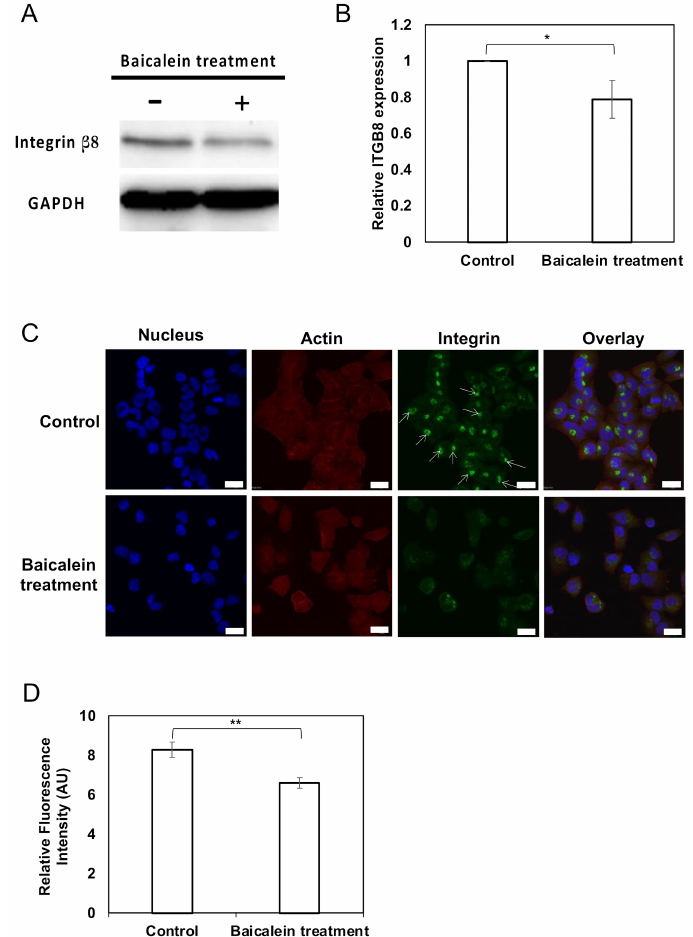
Figure 4. Validation of integrin β 8 expression in baicalein-treated NPC cells. ( A ) Protein expression of integrin β 8 in HK-1 cells with and without baicalein treatment. GAPDH was used as a loading control. Blots were cropped from the same gel to improve the clarity of protein-specific bands. ( B ) The relative protein expression of integrin β 8 was determined by Western immunoblotting. ( C ) Immunofluorescence staining of intracellular integrin β 8 protein in HK-1 cells. HK-1 cells were treated with 10 µ M baicalein for 24 h and fixed with 4% paraformaldehyde. The cells were then stained with primary integrin β 8 antibody, followed by Alexa-488-conjugated anti-mouse IgG. DAPI and TRITC-labeled phalloidin were used to counterstain the nucleus and actin, respectively. The arrows indicate the distinct pattern of integrin β 8 in control HK-1 cells. Scale bar represents 20 µ m. ( D ) The relative fluorescence intensity of baicalein-treated HK-1 cells compared to the control was determined by ImageJ software. All data represent the mean ± standard error of the mean (SEM) from three independent experiments, ** p < 0.01 and * p <